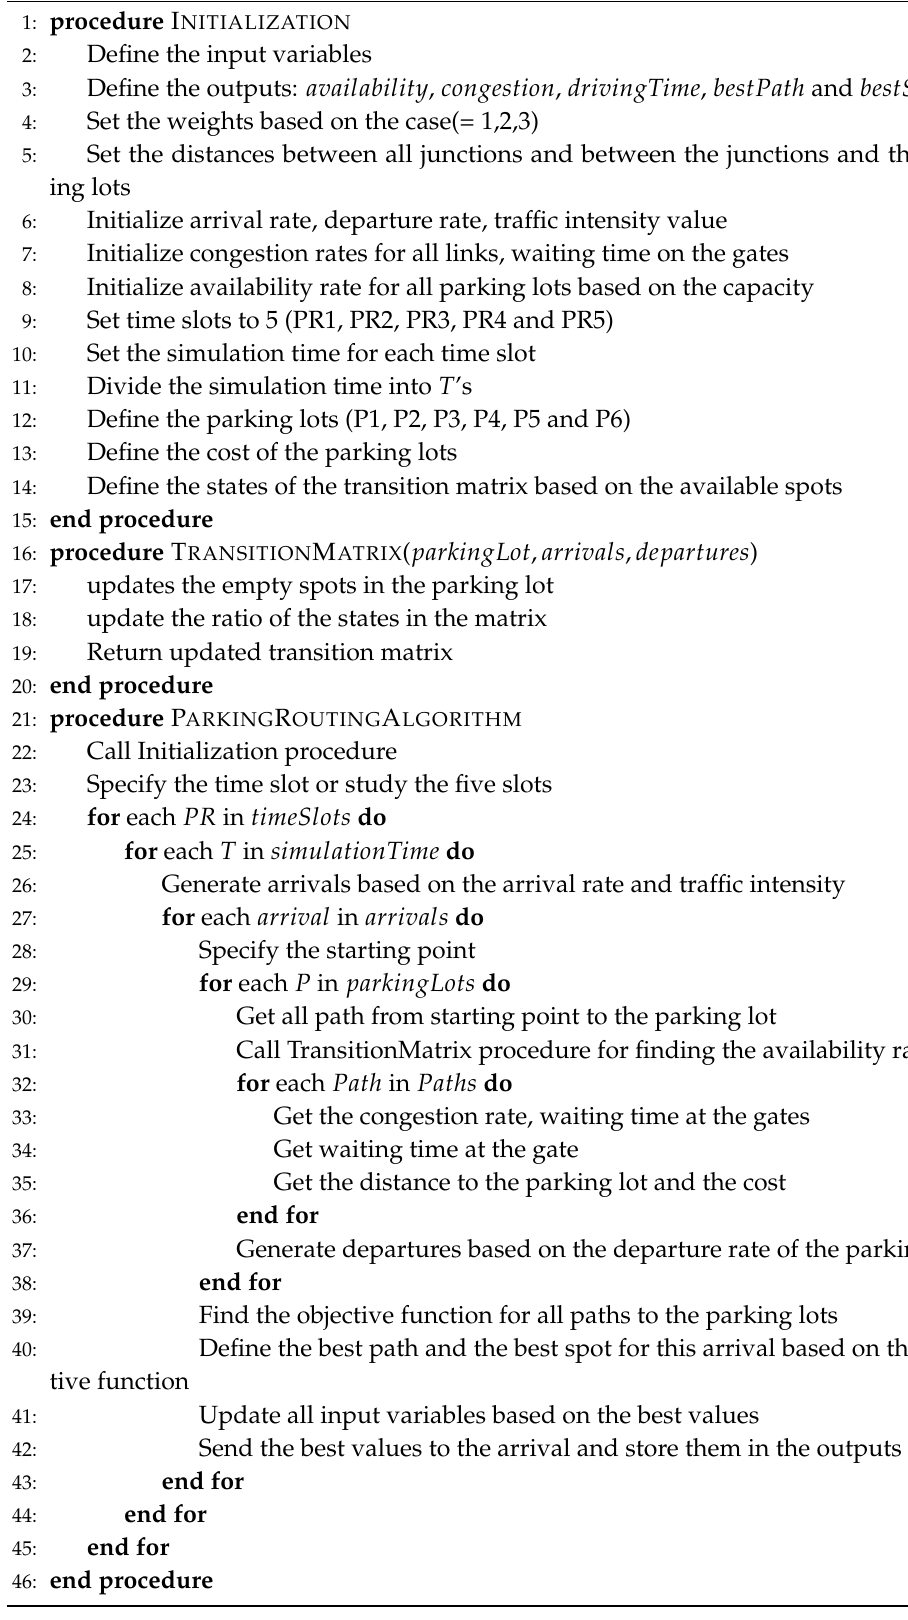
Algorithm 1 Pseudo code of the Parking and routing